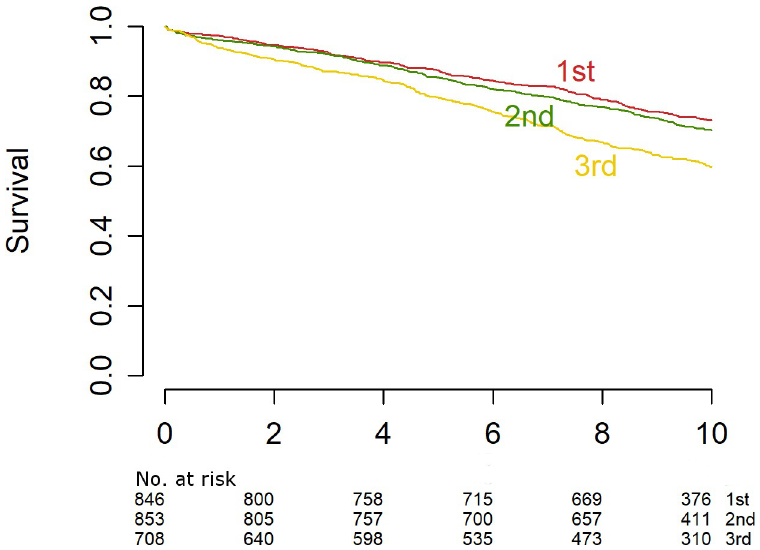
Fig 3. Survival curves showing the association of INR tertiles with all-cause mortality in LURIC patients with coronary artery disease. The first tertile (0.7–1.02) is drawn as a red line, the second tertile (1.02–1.08) as a green line and the third tertile (1.08–1.79) as a yellow line. The table below shows the number of study participants at risk to the respective time